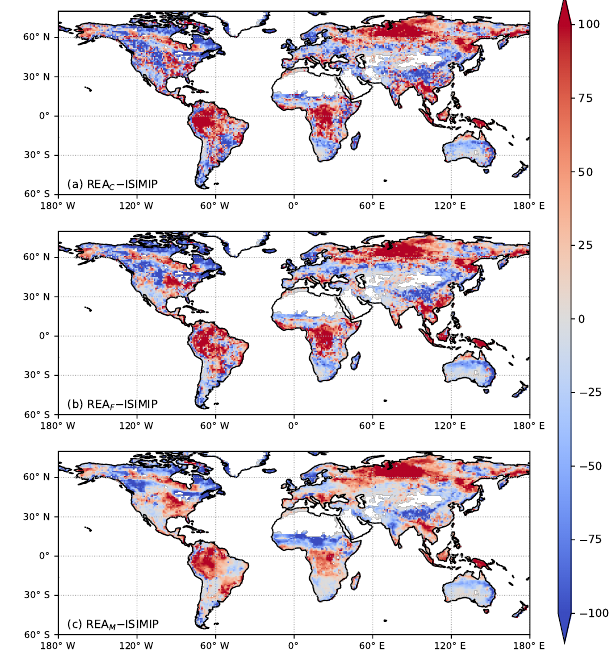
Figure 3. Ratio of the uncertainty in 21st century (cid:49) NPP from each REA average to the uncertainty in the ISIMIP ensemble. For ISIMIP, the uncertainty is calculated as the SD across the ensemble while the uncertainty around the REA averages is calculated follow- ing Eq. (4). Stippling indicates regions where there is an agreement on the sign of (cid:49) NPP through the